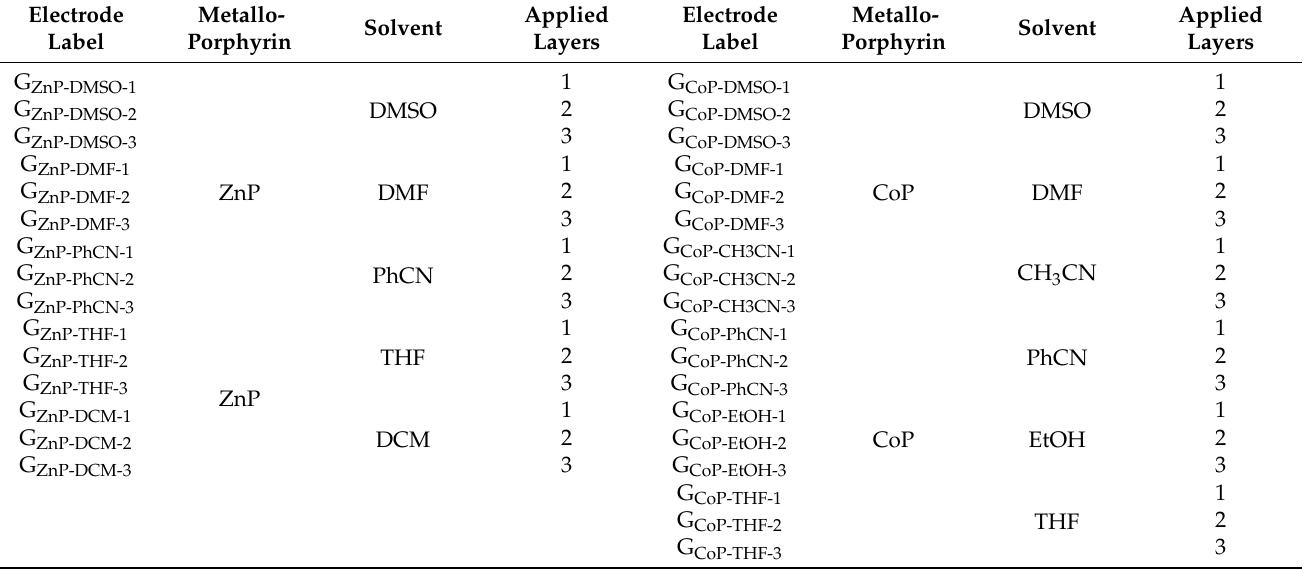
Table 1. The labelling of the modified